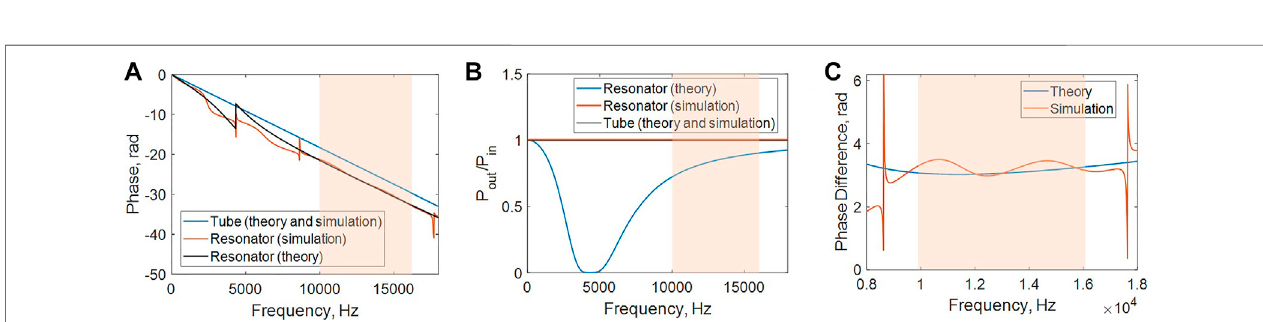
FIGURE 1 | System schematics and the transmission line circuit model for the two components of the phase shifter. (A) A tube and its effective circuit model as a delay line with impedance Z c . (B) A resonator and the effective circuit model at the location of the Helmholtz Resonator side branch.